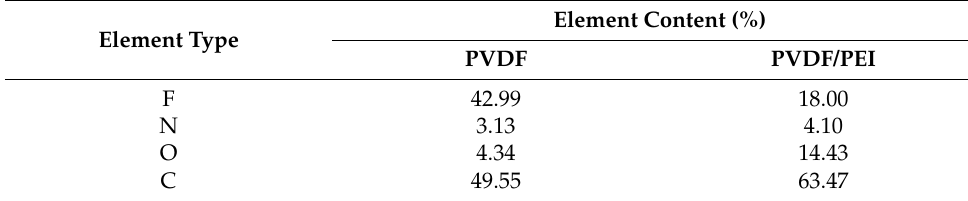
Table 2. XPS element content.